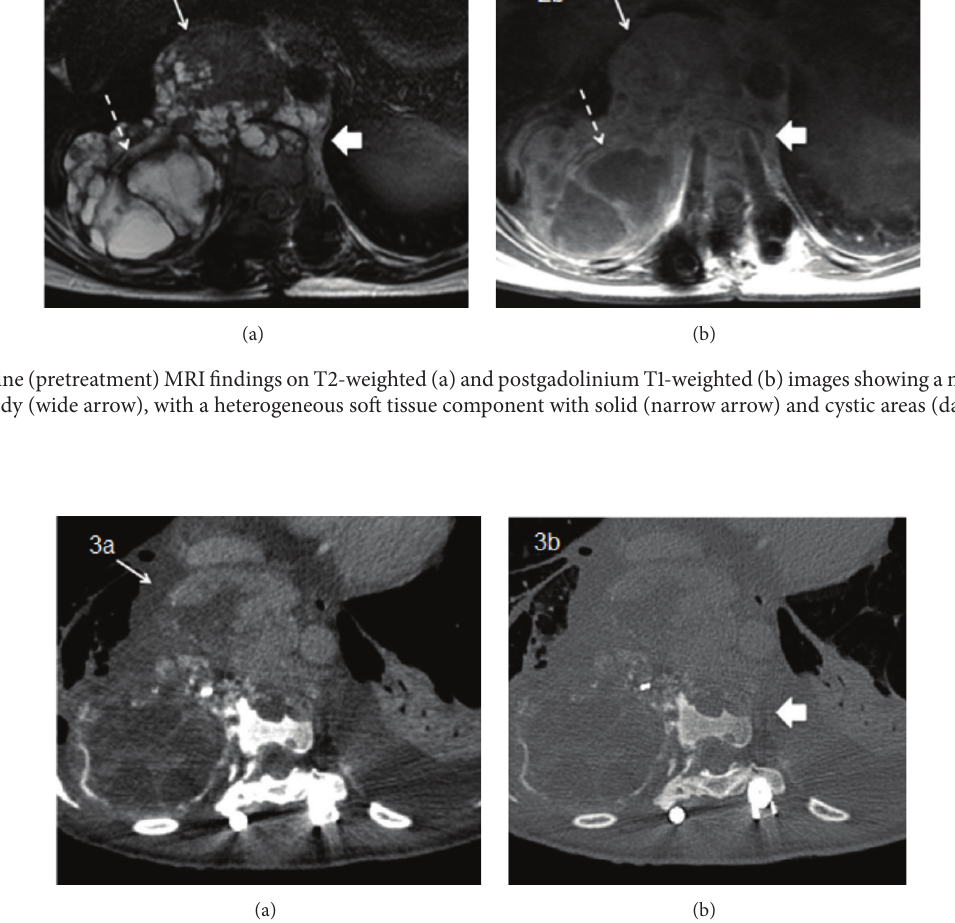
Figure 3: Postcontrast CT on soft reconstruction filter (a) and hard reconstruction filter (b), showing a lytic bone lesion arising from the vertebral body (wide arrow) with a large soft tissue component (narrow arrow).